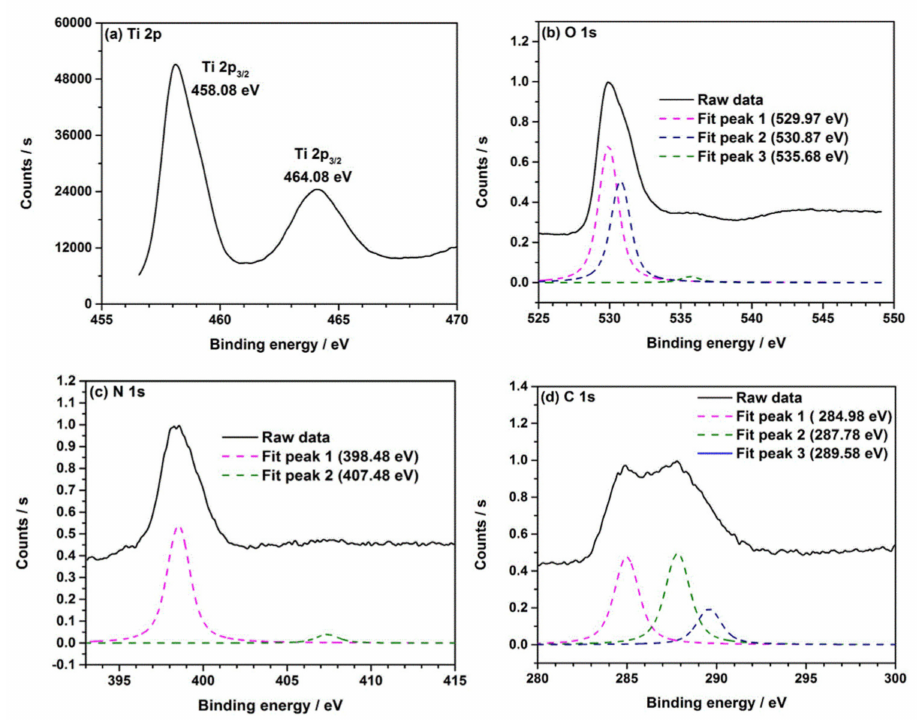
Figure 9. High resolution XPS spectra with peak fittings for pure NT-3 sample showing: ( a ) Ti 2p,